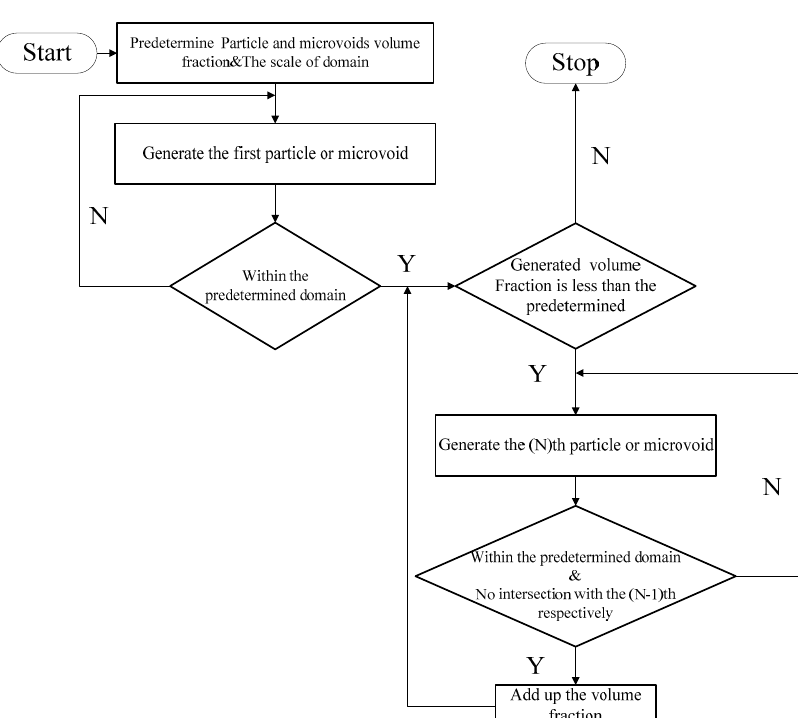
Figure 6. Flowchart of the reproduction process of the simulated microstructure of Al/PTFE.